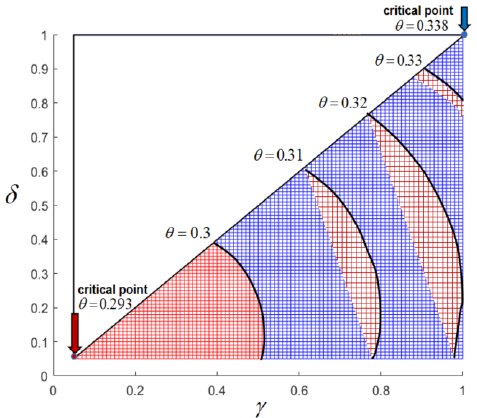
Figure 13. The boundaries and critical points on γ − δ